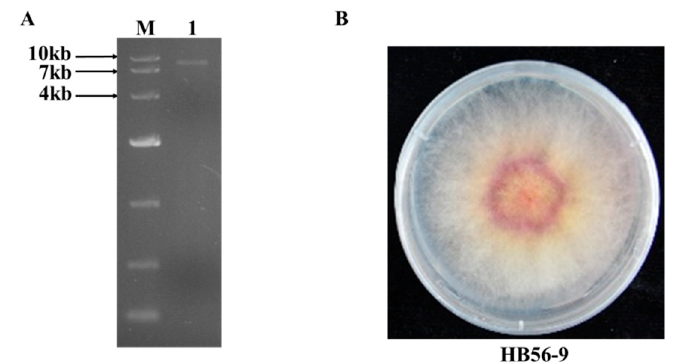
Figure 1. ( A ) dsRNA fraction extracted from F. graminearum strain HB56-9 was electrophoresed in a 1% agarose gel and visualized under UV light after staining with ethidium bromide. Lane M, DNA marker; Lane 1, dsRNA sample after treatment with S1 nuclease and RNase-free DNase I. ( B ) Colony morphology of strain HB56-9 after 4 days on PDA plate in the dark.